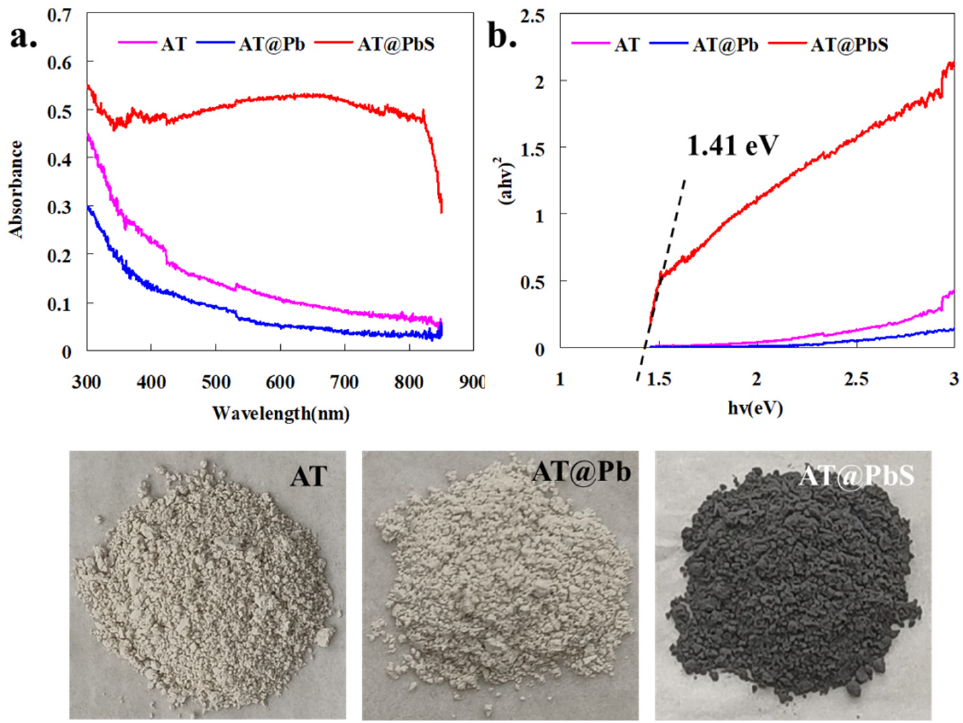
Figure 3. UV-Vis diffuse reflectance spectra for AT (attapulgite), AT@Pb (Pb-adsorbed saturated attapulgite), and AT@PbS (attapulgite/lead sulphide composite) ( a ), and the plotting results of band-gap energy for AT (attapulgit ) , AT@Pb (Pb-adsorbed saturated attapulgite ) , and AT@PbS (attapulgite/lead sulphide composite ) ( b ).